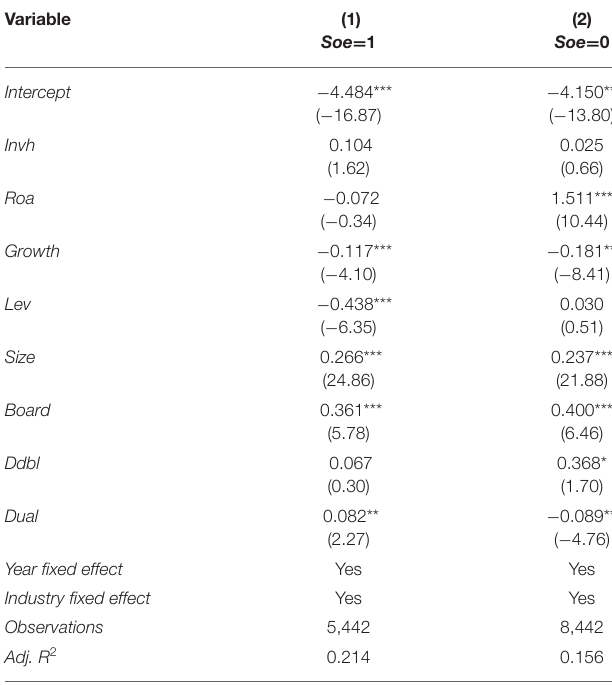
TABLE 13 | Shareholding ratio of institutional investors and environmental information disclosure quality: group test of state-owned and non-state-owned